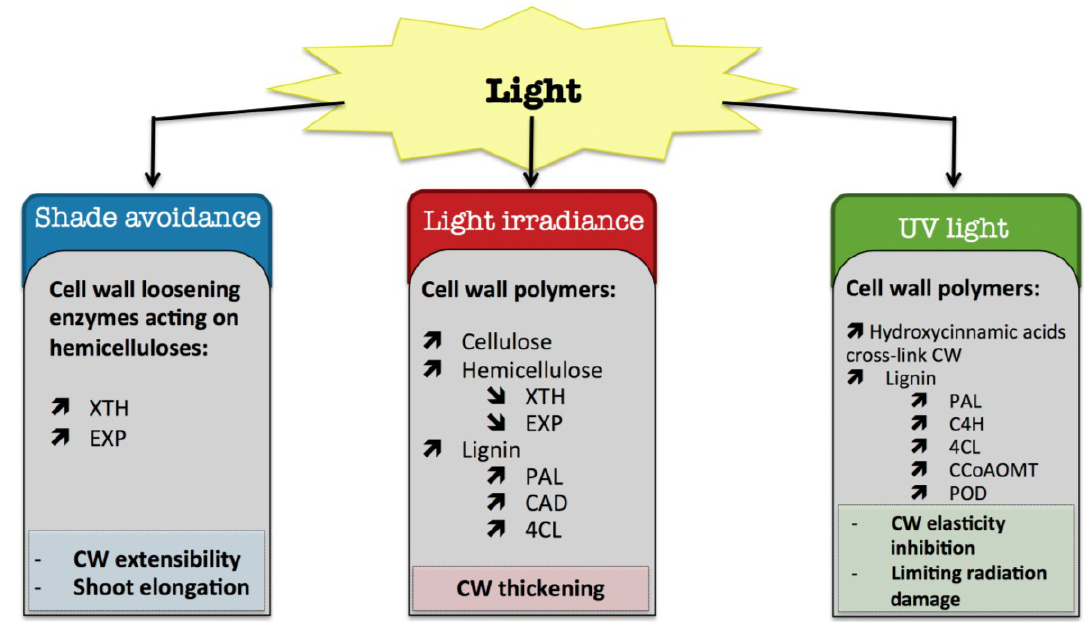
Figure 7. Diagram summarizing the plant cell wall response to light. The schematic presentation is deduced from the results of different studies reported in the review. Arrow (  ) means increased abundance and arrow (  ) means decreased abundance of the molecules. Star (  ) means contrasting data on the gene/protein or the molecule studied according to the literature cited in the review. Cell wall (CW); xyloglucan endo-β-transglucosylases/hydrolases (XET/XTH); expansin (EXP); phenylalanine ammonia- lyase (PAL); hydroxycinnamyl alcohol dehydrogenase (CAD); 4 coumarate CoA-ligase (4CL); caffeoyl-CoA 3- O -methyl-transferase (CCoAOMT); trans-cinnamate 4-hydroxylase (C4H); cell wall peroxidases